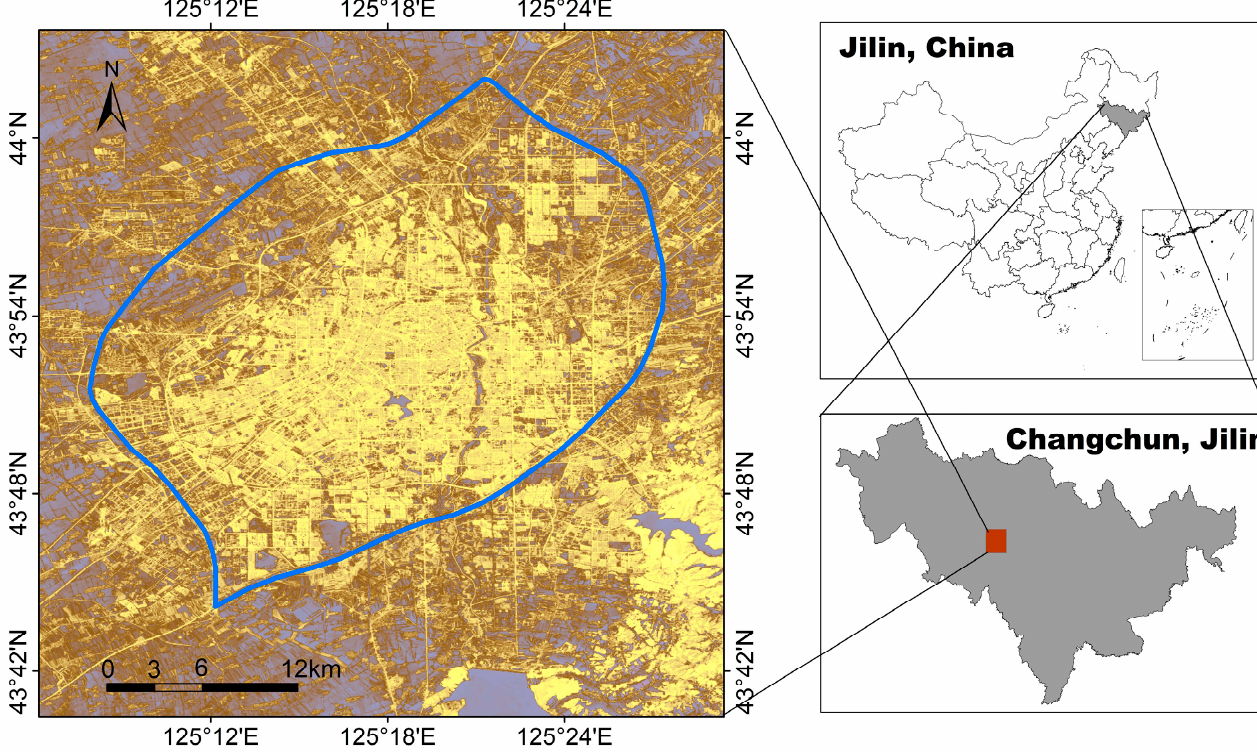
Table 1. Selected indicators of waterlogging risk model and their source.